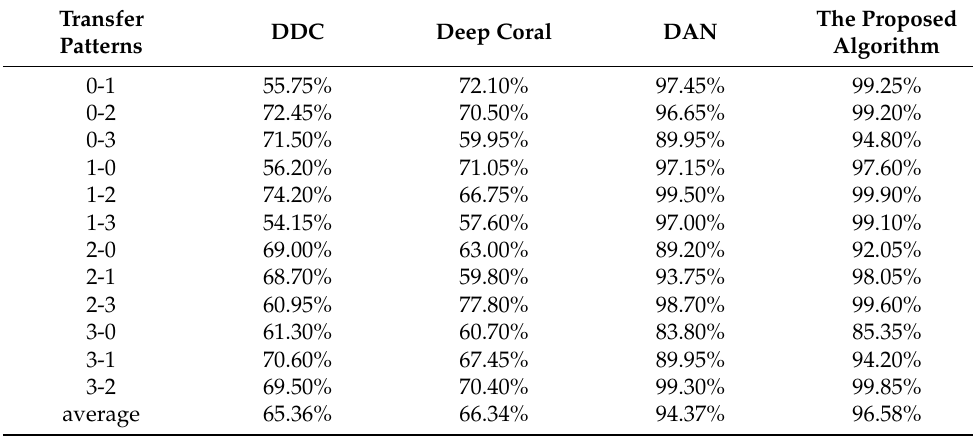
Table 2. The accuracy of fault diagnosis under different working conditions.